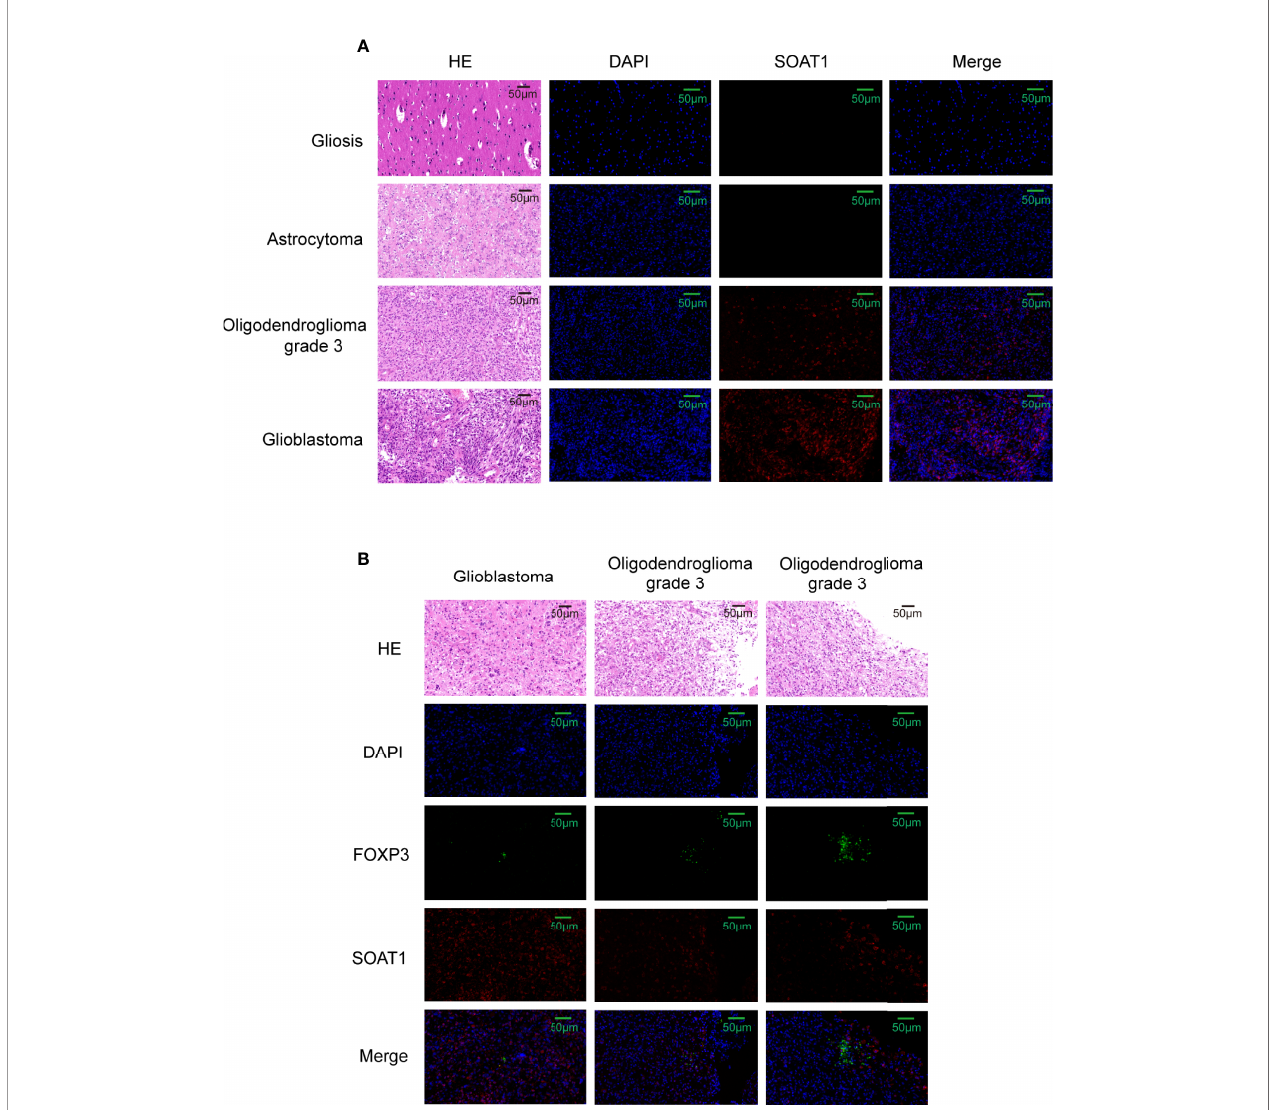
FIGURE 5 | Correlation between SOAT1 expression and Treg in fi ltration was not strong. (A) Representative HE images and immuno fl uorescence images of SOAT1 expression in glioma, astrocytoma grade 2, oligodendroglioma grade 3, glioblastoma. (B) The co-localization of high expression of SOAT1 with FoxP3+ Treg in fi ltration in glioma. SOAT1 , sterol O-acyltransferase 1 ; Treg, T regulatory